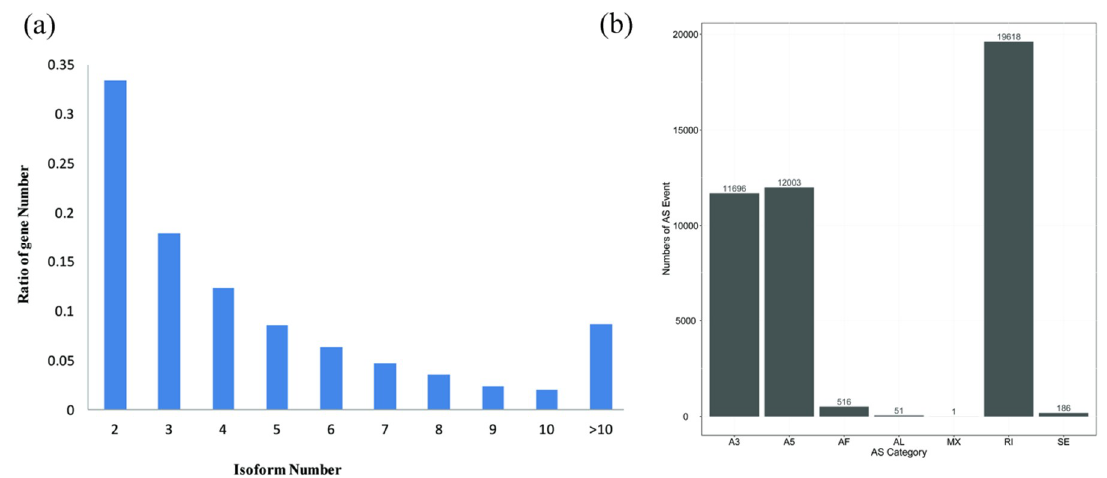
Figure 4. Analysis of alternative splicing (AS) events. ( a ) Distribution of isoform numbers for the genes. ( b ) Classification of AS events.